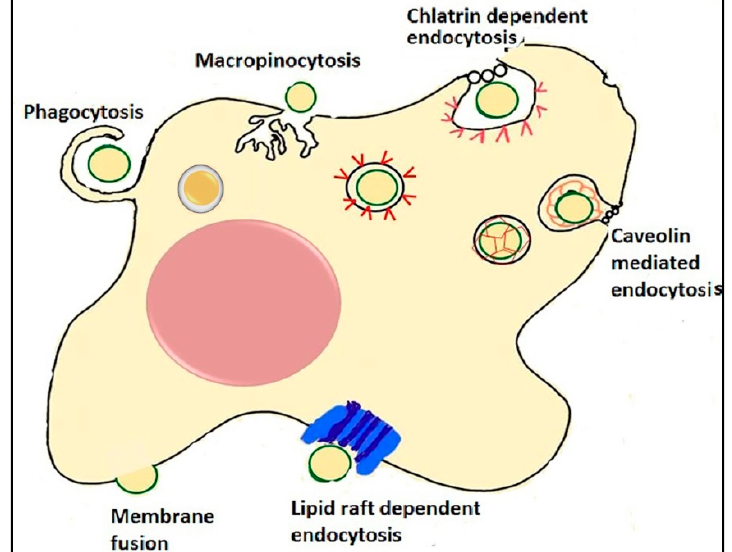
Figure 2. Mechanisms of EV uptake. EVs can be internalized by cells through different endocytic processes. During phagocytosis, the cytoplasm creates invaginations around the EV, which is then internalized creating an endosome. During macropinocytosis, plasma membrane ruffles fold back on themselves around the EVs, forming a lumen of a macropinosome. Clathrin-dependent endocytosis induces membrane curvature around the EV. In caveolin-mediated endocytosis caveolae (small, cave-like invaginations in the cell membrane) with EVs inside are internalized into the cell. Intracellularly, they develop chlatrin- or caveolin-coated vesicles, fuse with endosomes and deliver the cargo. EV uptake can occur by interaction of EVs with lipid rafts. Lipid rafts are involved in both clathrin- and caveolin-mediated endocytosis. Another possible way for EVs to deliver their cargo to recipient cell is by passive fusion with the plasma membrane.